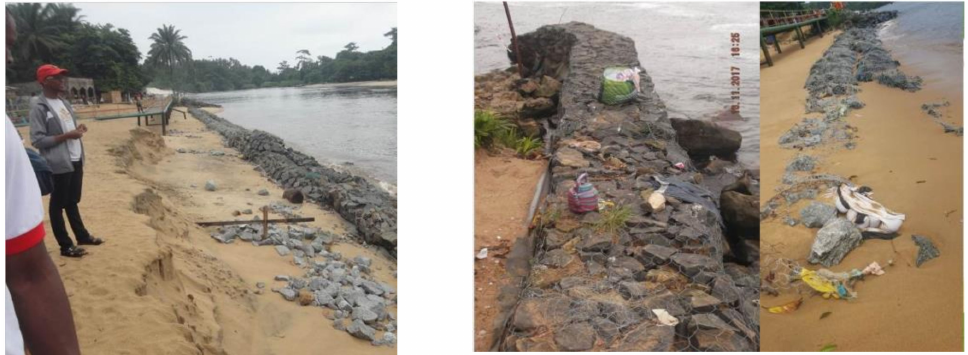
Figure 19. Construction of a protective dyke at the Lob é waterfalls in Kribi. (Credit: Mbevo, 2017; Tchindjang,